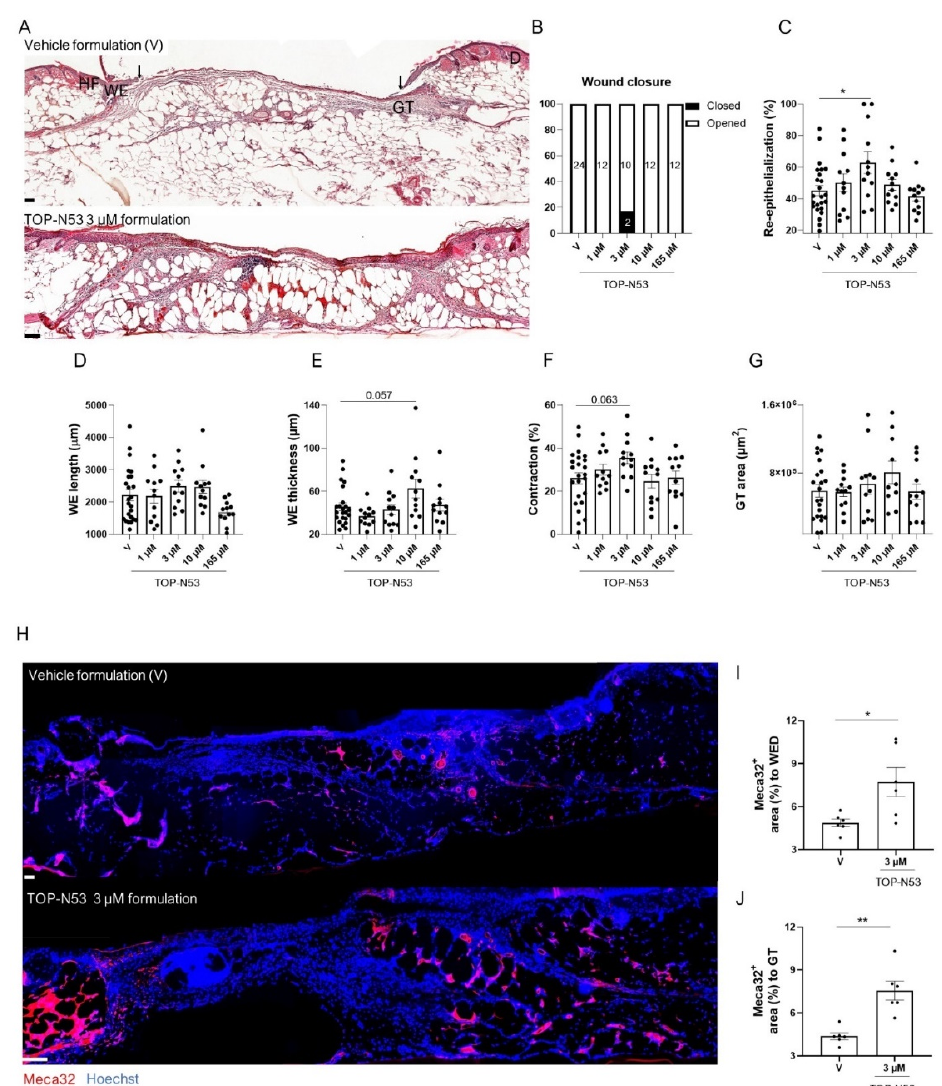
Figure 4. TOP-N53 liquid hydrogel formulation promotes wound re-epithelialization and angiogenesis in healing-impaired diabetic mice. ( A ) Representative photomicrographs of hematoxylin/eosin-stained paraffin sections from 5-day wounds of diabetic db/db mice treated with vehicle hydrogel formulation (V) or TOP-N53 3 µM liquid hydrogel formulation. Magnification bars: 100 µ